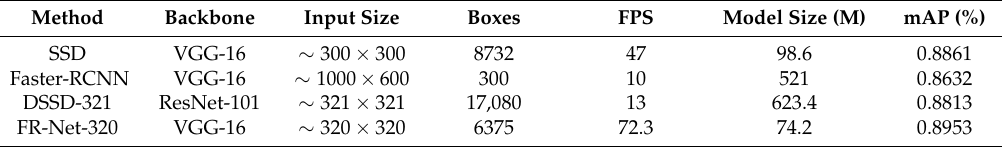
Table 3. Comparison results with the state-of-art on the railway traffic